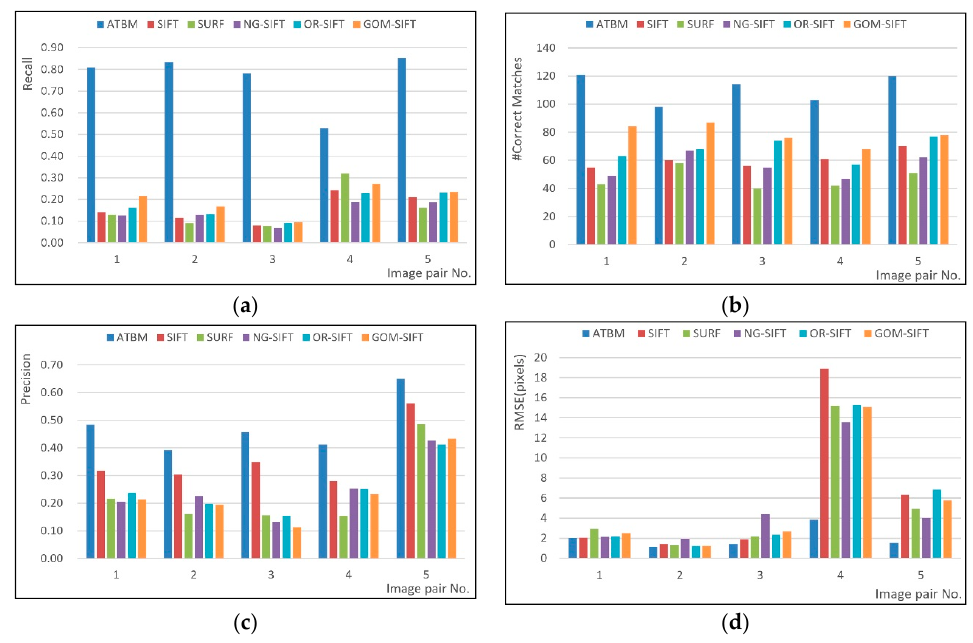
Figure 11. Quantitative matching results of test images: ( a ) Matching recall; ( b ) number of correct matches; ( c ) matching precision; and ( d ) positional accuracy.